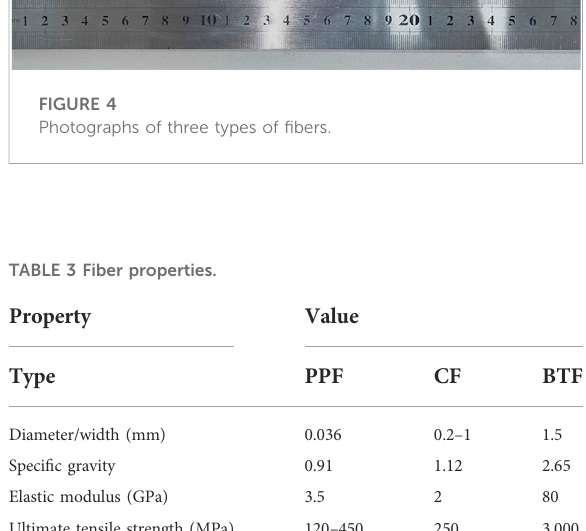
FIGURE 4 Photographs of three types of fi bers.